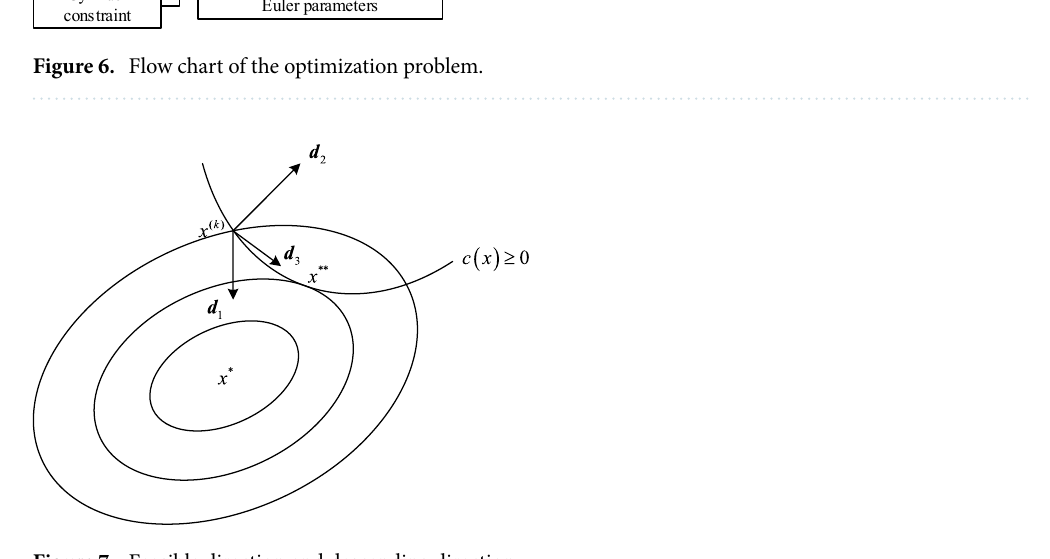
Figure 7. Feasible direction and descending